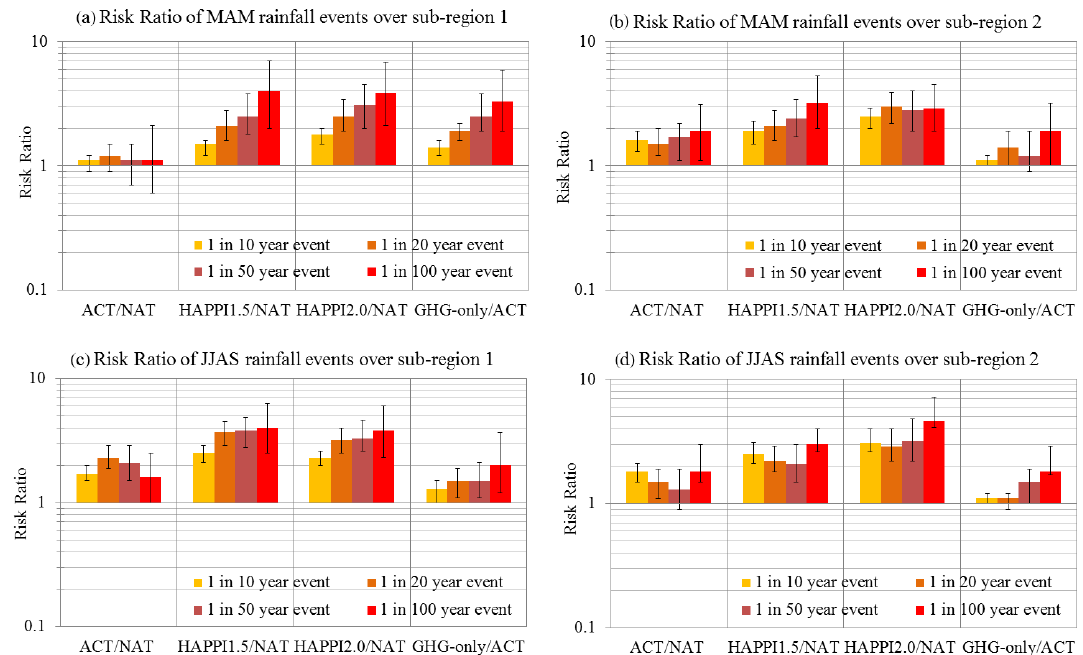
Figure 10. The risk ratios of four specific rainfall events with return periods of 10, 20, 50, and 100 years between ACT/NAT, HAPPI 1.5/NAT, HAPPI 2.0/NAT, and GHG-only/ACT over the two northern sub-regions 1 and 2 during MAM (a, b) and JJAS (c, d) . The error bars indicate the associated uncertainty range with 95% confidence level for individual events.